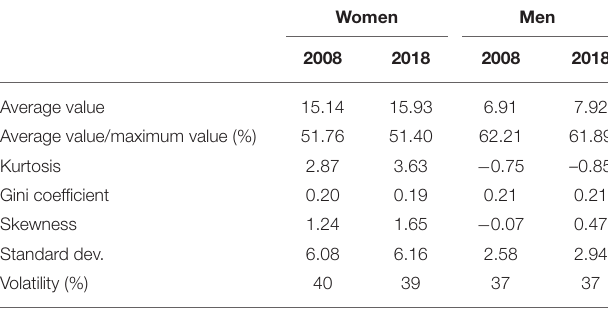
TABLE 6 | KILM 13—descriptive statistics for the years 2008 and 2018.